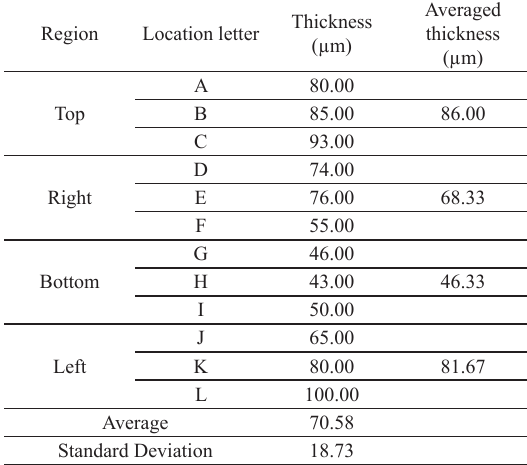
Table 1. Film thickness measurements according to the regions described in Figure 2.